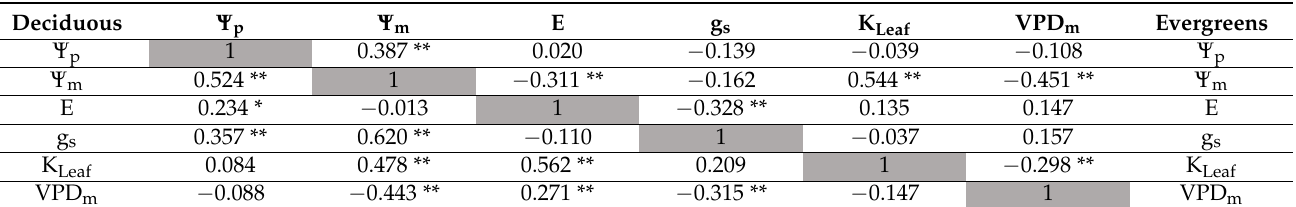
Table 2. Pearson correlation between predawn ( Ψ p ) and midday leaf water potential ( Ψ m ), transpi- ration rate (E), stomatal conductance (g s ), leaf hydraulic conductance (K Leaf ) and midday Vapour Pressure Deficit (VPD m ) for deciduous (left) and evergreen (right)